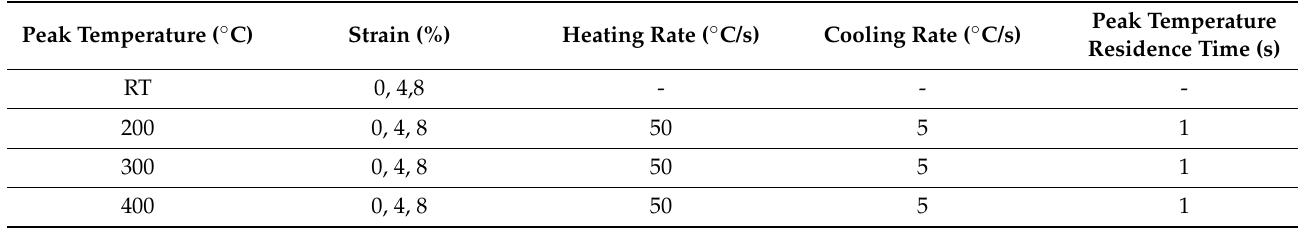
Table 1. Experimental parameters of thermal cycle. RT: Room temperature.